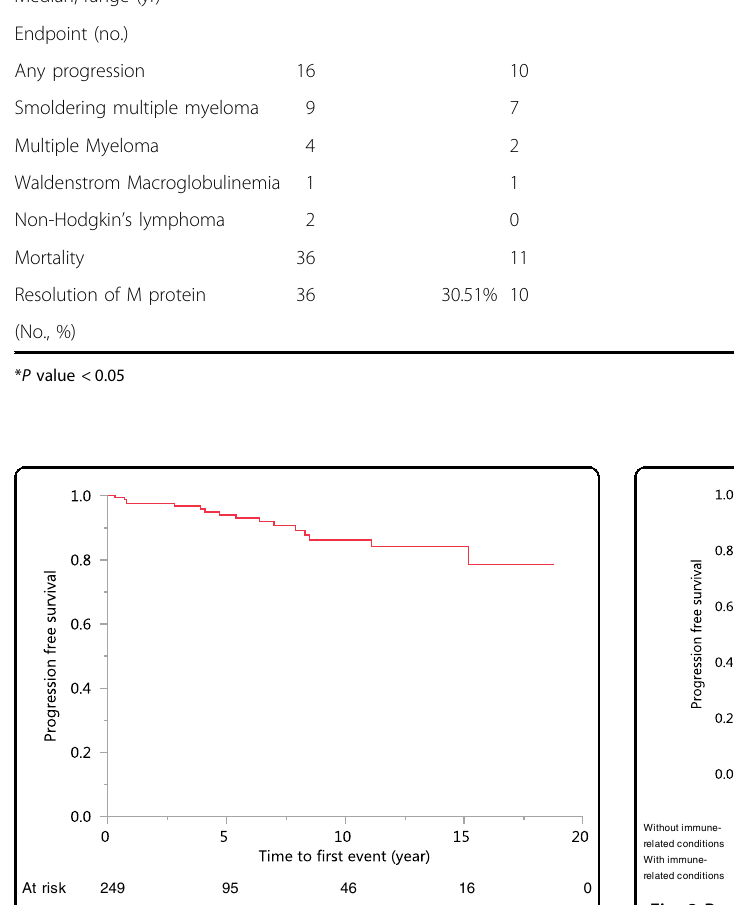
Fig. 1 Progression-free Survival of Young Patients with MGUS. For the entire cohort, the risk of progression at 1 year, 2 years, 3 years, 4 years, 5 years and 10 years is respectively, 2.4%, 2.4%, 3.2%, 4.1%, 6.0%, and 13.8%.